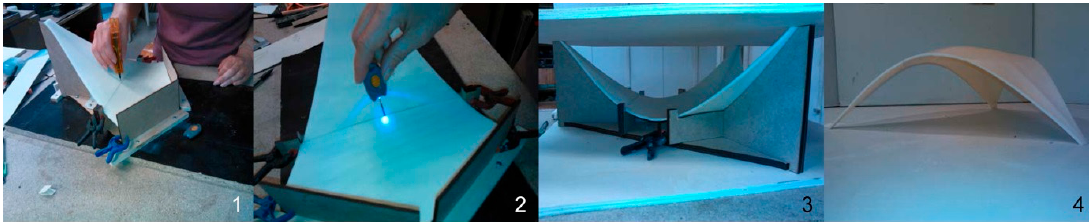
Figure 8. Assembling process: ( 1 ) linking (third part) through glue points; ( 2 ) speed dry using Ultraviolet Light-emitting diode (UV LED); ( 3 ) linking all parts; ( 4 ) stabilized shell.